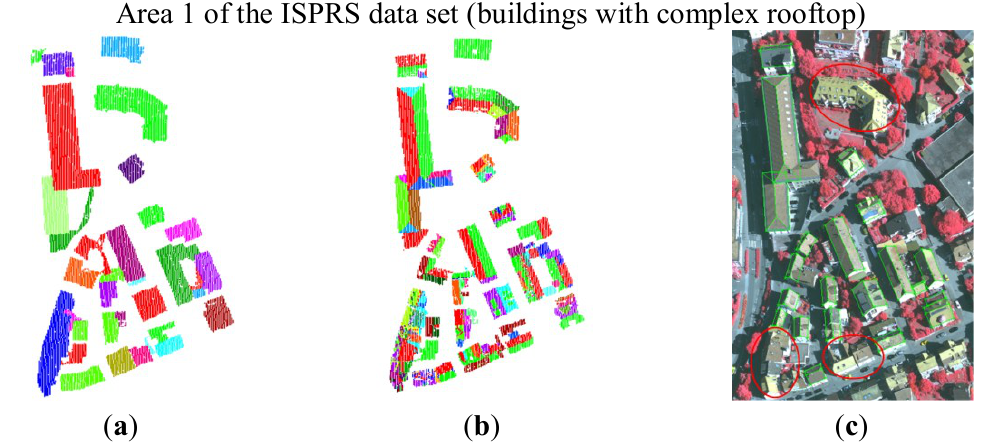
Figure 13. Building roof modeling results of Area 1 and Area 2 using the proposed modeling method. ( Left Panel ) ( a ) and ( d ): Building blocks segmentation result (different colors indicate different building clusters); ( Middle Panel ) ( b ) and ( e ): Rooftops segmentation result (different colors indicate different rooftop planar patches); ( Right Panel ) ( c ) and ( f ): Building roof modeling result (green wireframes) superimposed on the aerial